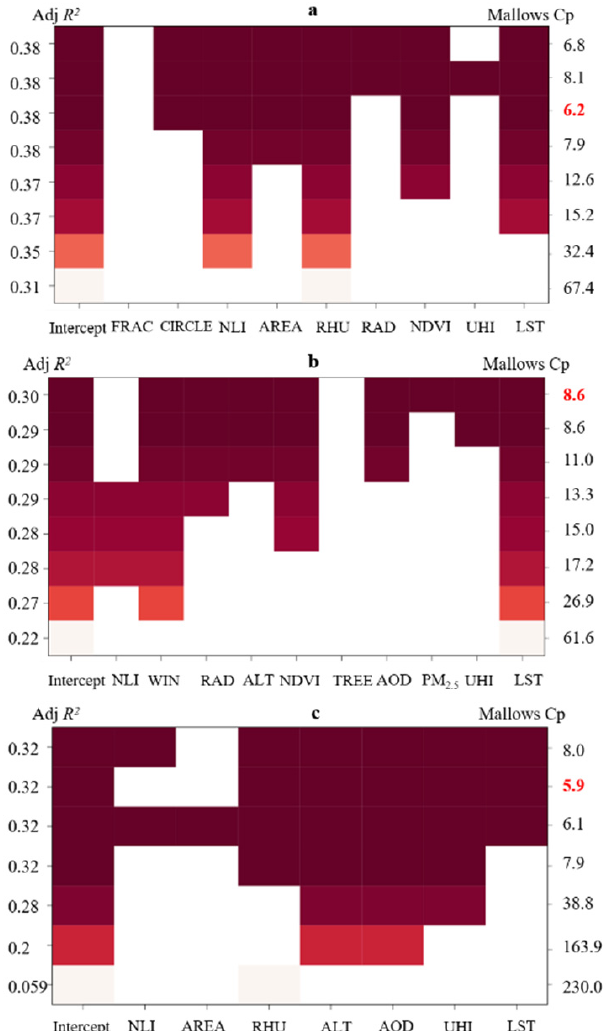
Figure 7. Results of the optimal full subset regression ( a ), summer; ( b ), winter; ( c ), annual; the red font on the right indicates that the model was the best model).